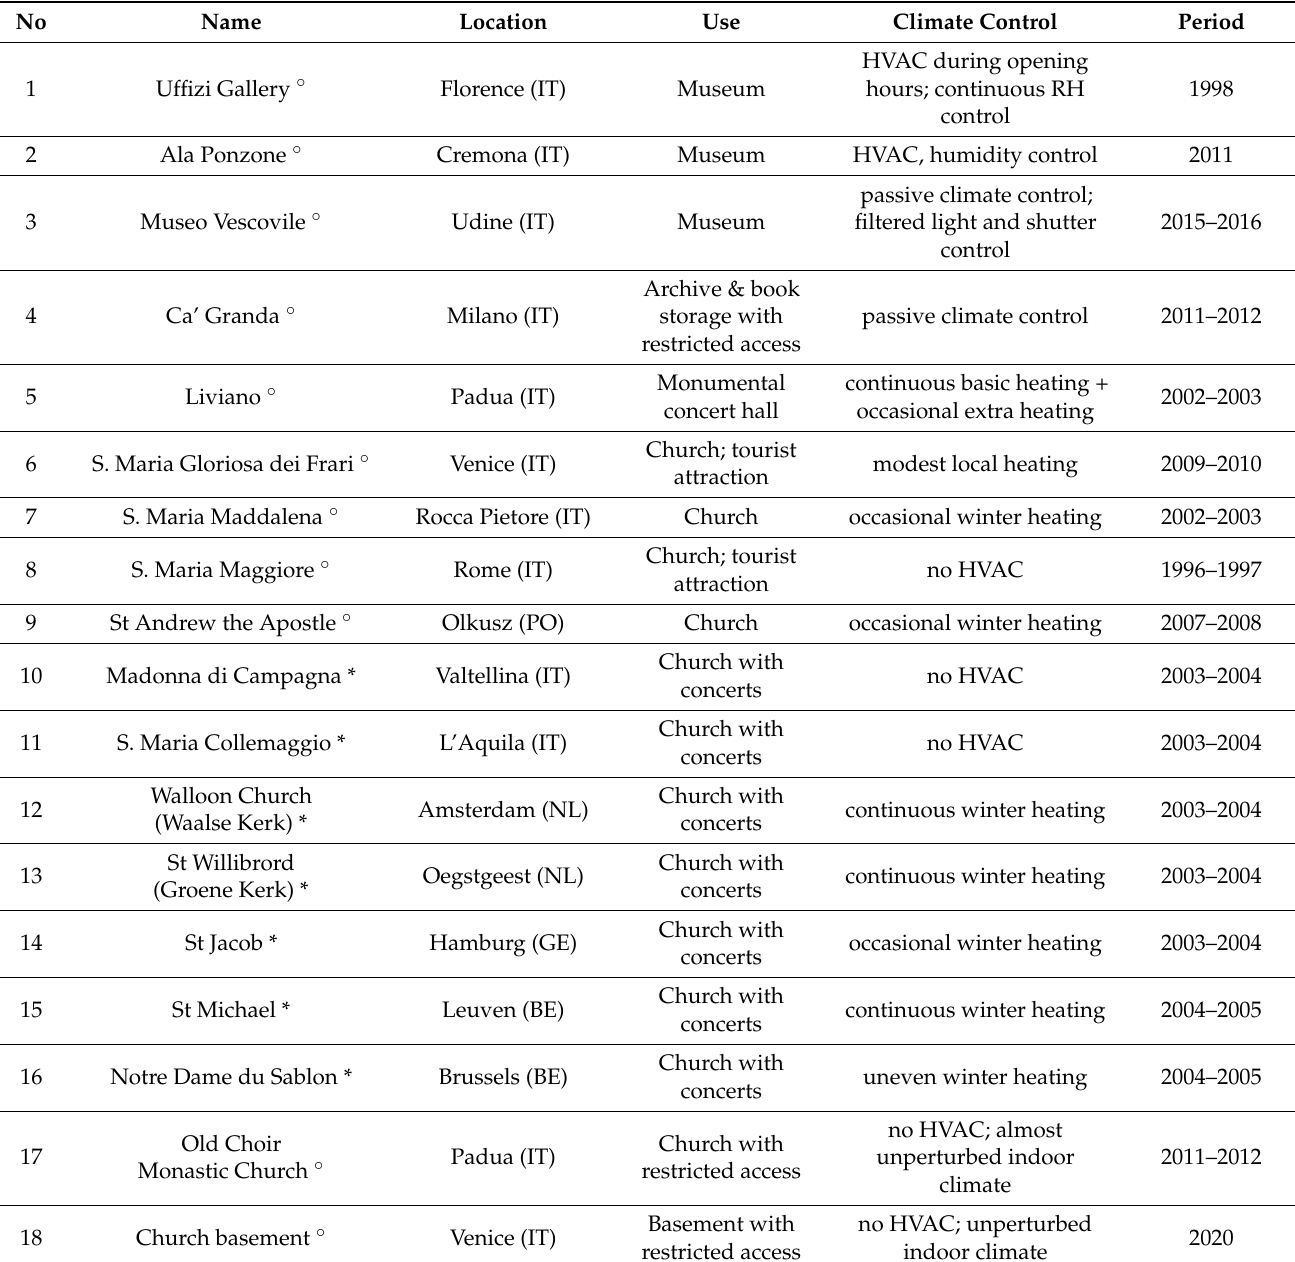
Table 1. Characterization of the case